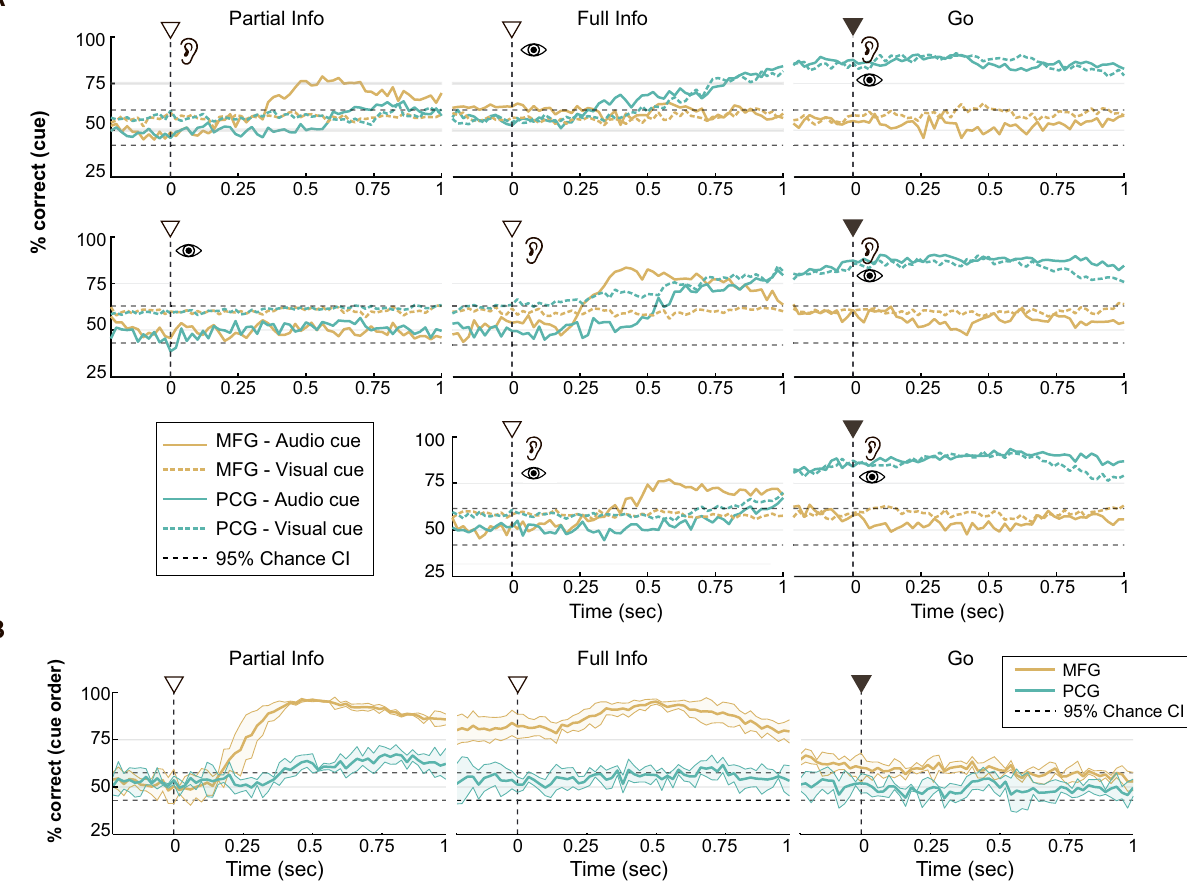
Figure 4. MFG is specifically engaged during auditory cue processing and not visual or multi-modal cue processing. ( A ) Classification accuracies of SVM models designed to distinguish trials on which the target was cued with different auditory cues ( solid lines ; red vs blue auditory cues) or different visual cues ( dashed lines ; square vs circle visual cues) using ensembles of MFG ( yellow ) and PCG ( teal ) neurons in the AV task sequence ( top row ), VA task sequence ( middle row ), and A + V task sequence ( bottom row ) in the Multi-modal Cues task. ( B ) Classification accuracies for discrimination between AV versus VA trials using MFG (yellow) and PCG ( teal